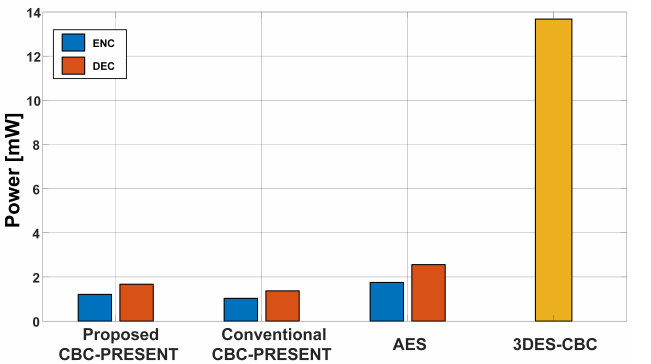
Figure 13. Die area occupation of the proposed CBC-PRESENT when compared to a conventional design and AES.